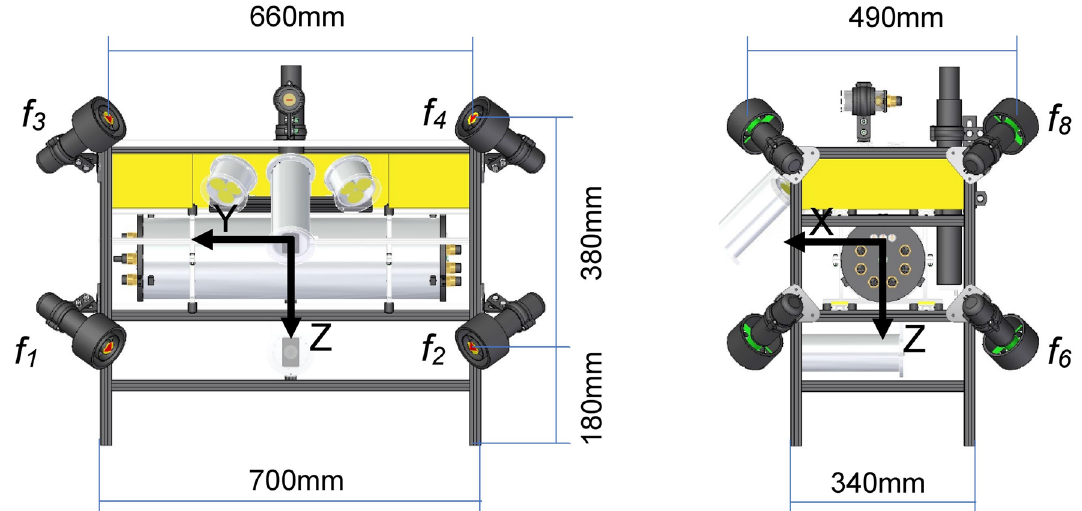
Fig. 11 Physical parameters. Thrusters that generate forces of f 5 and f 7 N are located respectively behind the first and third thrusters ( f 1 and f 3